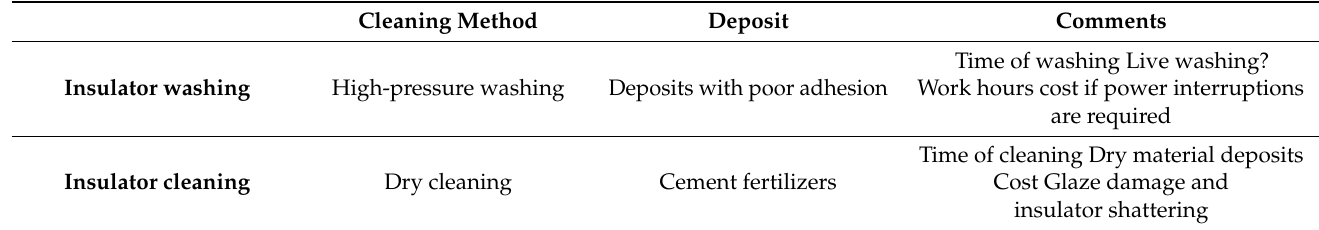
Table 5. The insulator washing methods.